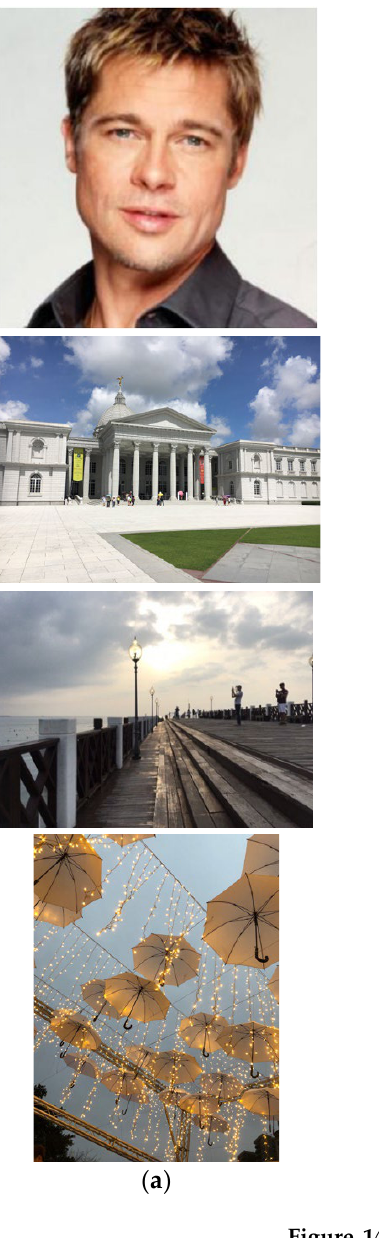
Figure 14. The results of the proposed method image transfer with different types of images. ( a ) Content image. (Top: “Brad Pitt” [28].) ( b ) Target image. From the WikiArt database. ( c ) After completing the adaptive multilevel image color transfer and selecting specific convolution layers according to the target image, the final result of the style transfer is displayed.